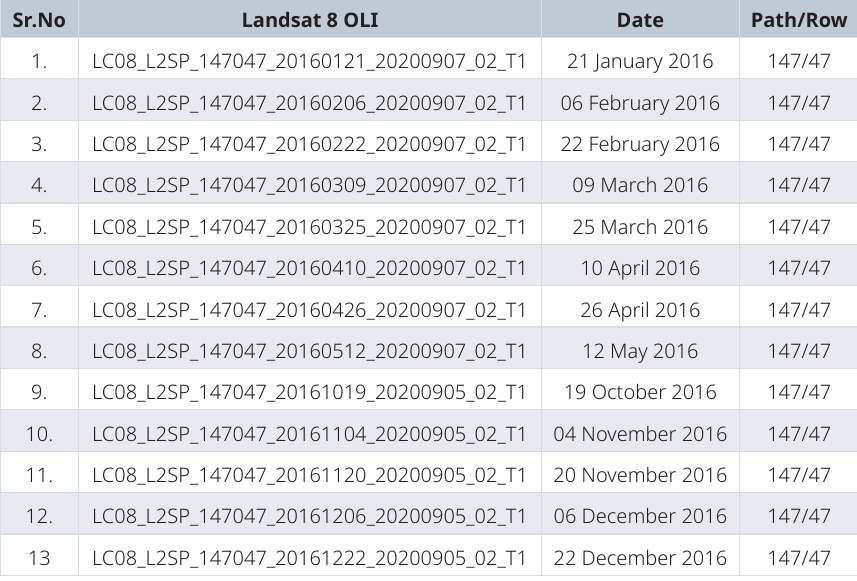
Table 1. Landsat 8 Operational Land Imager (OLI) images downloaded and analysed in this study. Sr.No Landsat 8